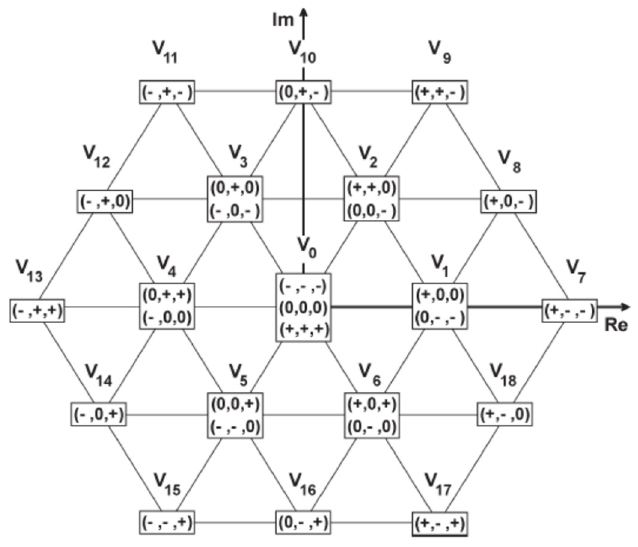
Figure 2. Space vectors of NPC 3- φ inverter.